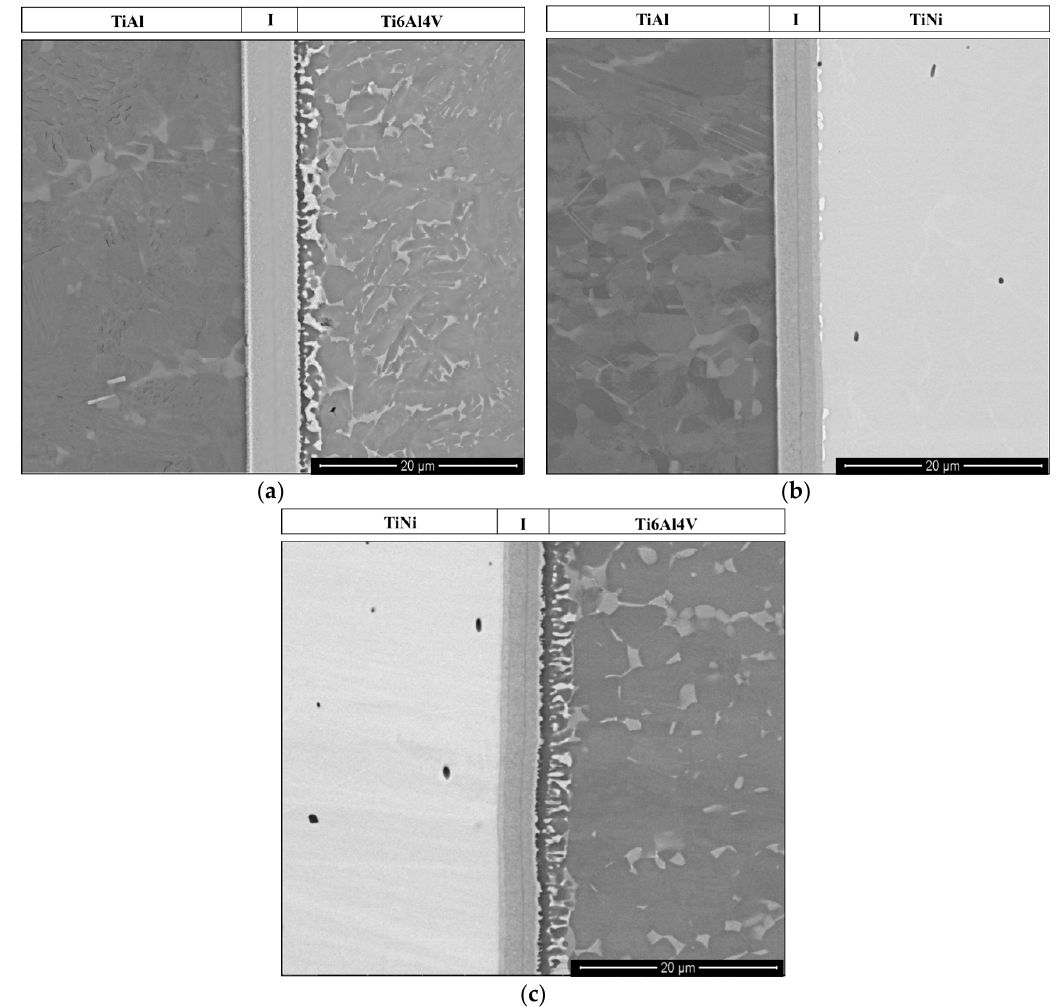
Figure 2. SEM images of the ( a ) TiAl/Ti6Al4V, ( b ) TiAl/TiNi and ( c ) TiNi/Ti6Al4V interfaces, I, produced at 800 °C under a pressure of 20 MPa using Ni/Al nanolayers.